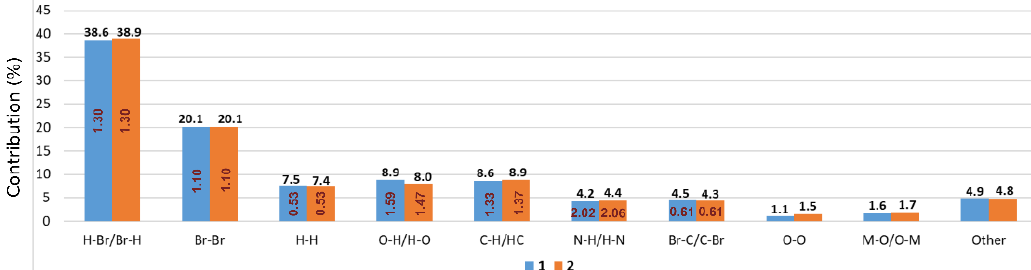
Figure 10. Percentage contribution of particular interatomic contacts to the Hirshfeld Surface areas for 1 (blue) and 2 (orange). The chart is decorated with respective enrichment ratio (ER) values (in red). ER values were not computed for actual contacts contribution below 2% and random contacts below 1% since they are not meaningful.